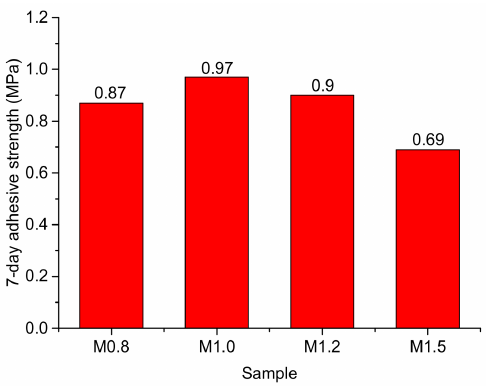
Figure 9. Adhesive strength at the age of 7